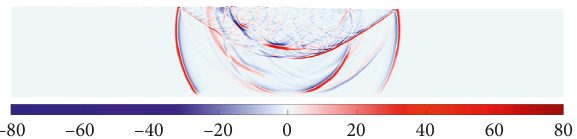
Figure 14: Velocity distribution in the x direction at time � 25s.